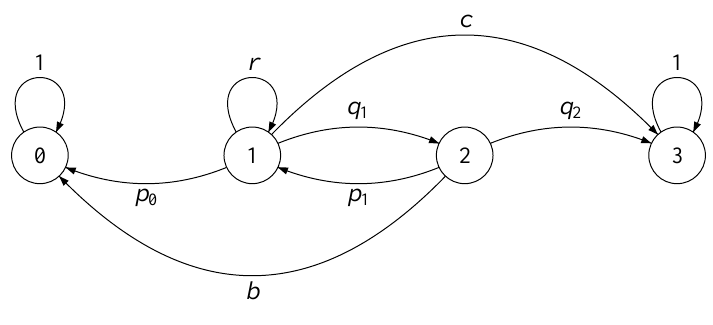
Fig. 3: The randomization of the process depicted in Figure